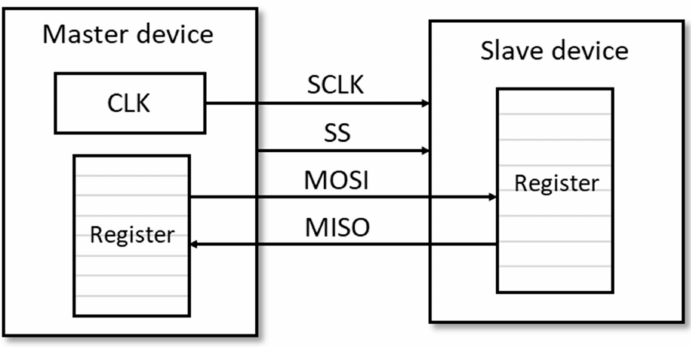
Figure 1. Traditional 4-wire serial peripheral interface (SPI) protocol block